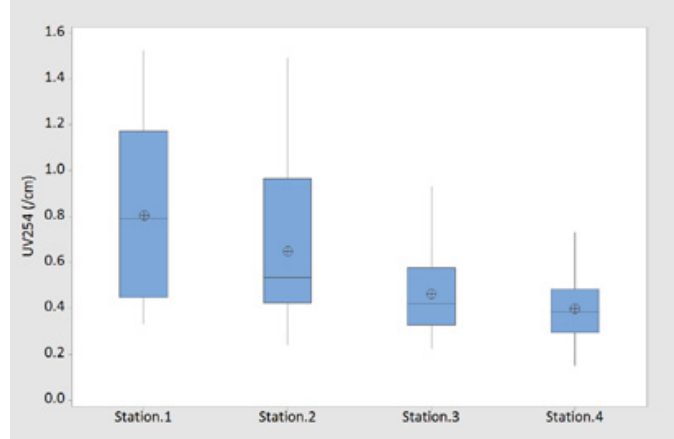
Fig. 3: The average UV 254 concentration in the river segment at various station